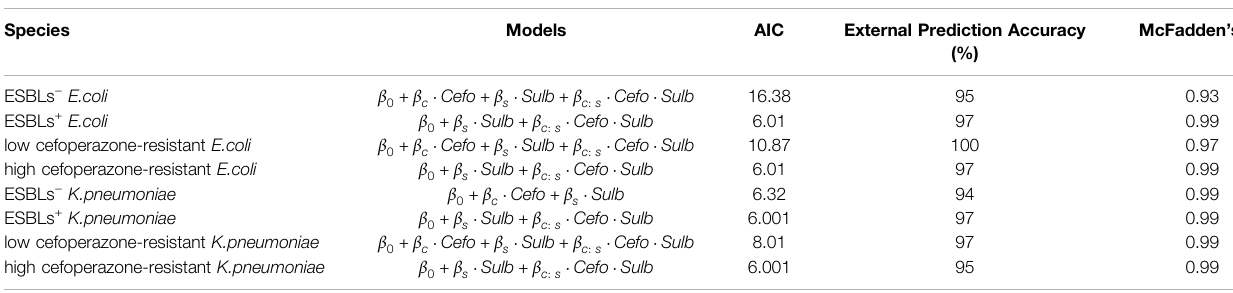
TABLE 5 | The selected logistic models for the tested bacteria. Species Models